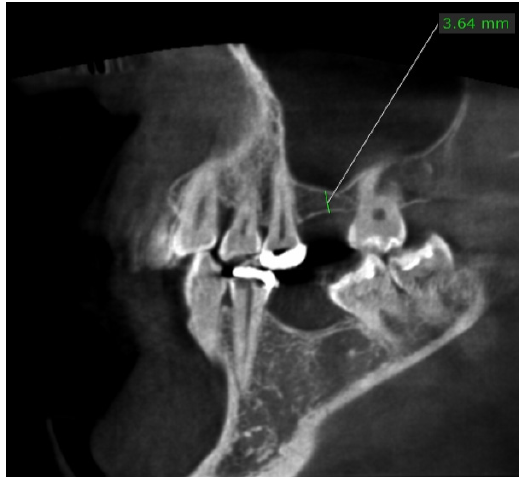
Figure 1. The section of the CBCT showing a residual height of 3.6 mm before the sinus lift at baseline. On the same week, a sinus lift using the crestal approach was performed: after a crestal incision and a full flap between dental elements 25 and 27, a small drill was used to prepare the implant site (Drill-Kit, MICERIUM S.p.A., Genova, Italy), but instead of proceeding to the implant placement, only equine collagen was placed (Condress ® ). The site preparation was performed until the sinus membrane was visible. After the collagen insertion, two sheets of collagen sponge cut into strips of about 5 mm wide were placed gently in an apical direction, and the future implant site was sutured by two detached mattress stitches, and a gel with hyaluronic acid was applied (Aminogam gel ® ).